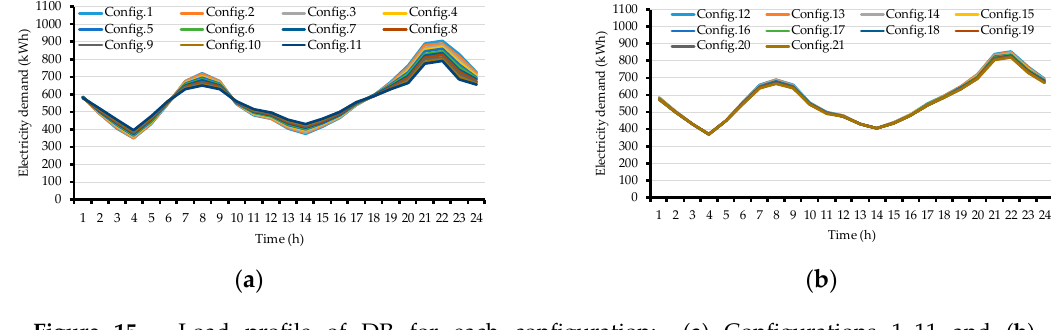
Figure 15. Load profile of DR for each configuration : ( a ) Configurations 1–11 and ( b ) Configurations 12–21.